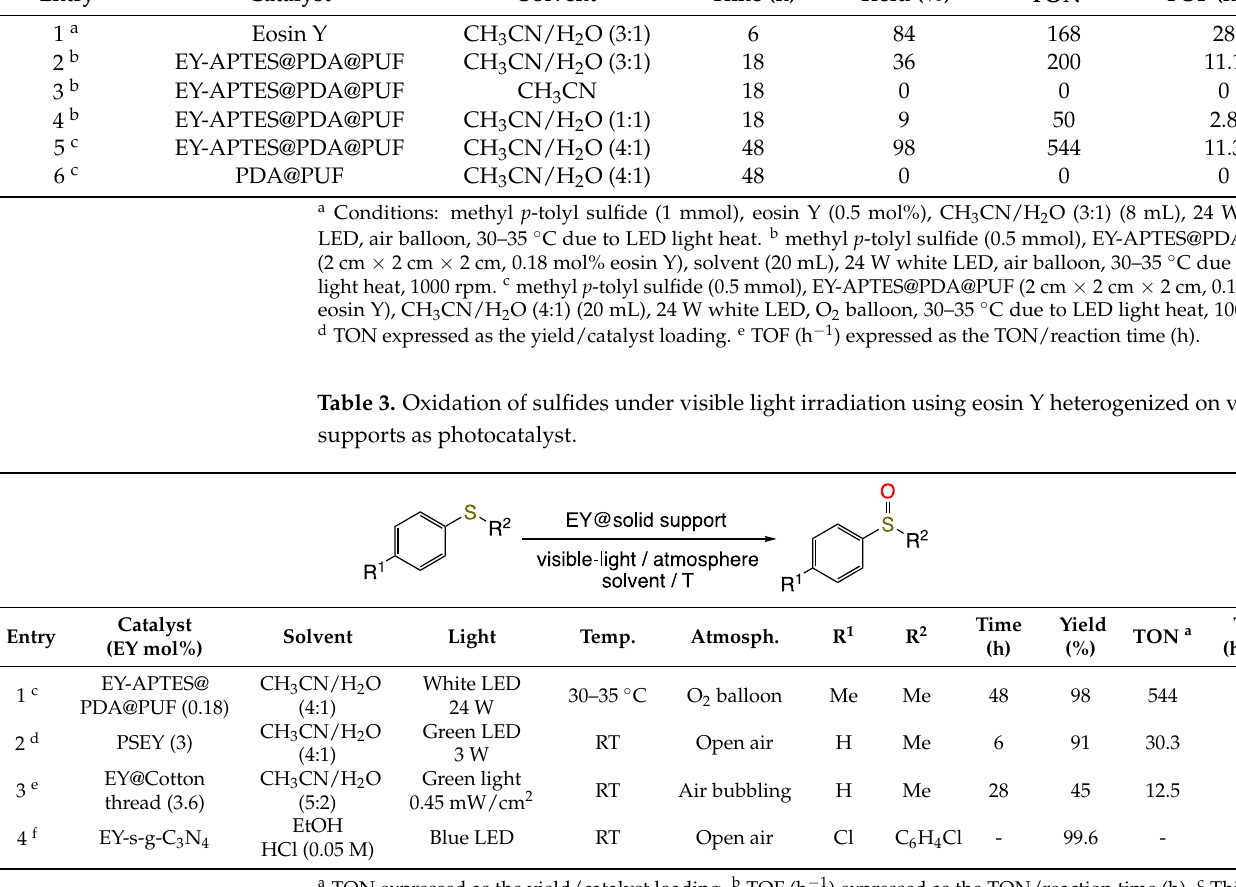
Table 3. Oxidation of sul fi des under visible light irradiation using eosin Y heterogenized on various supports as photocatalyst.